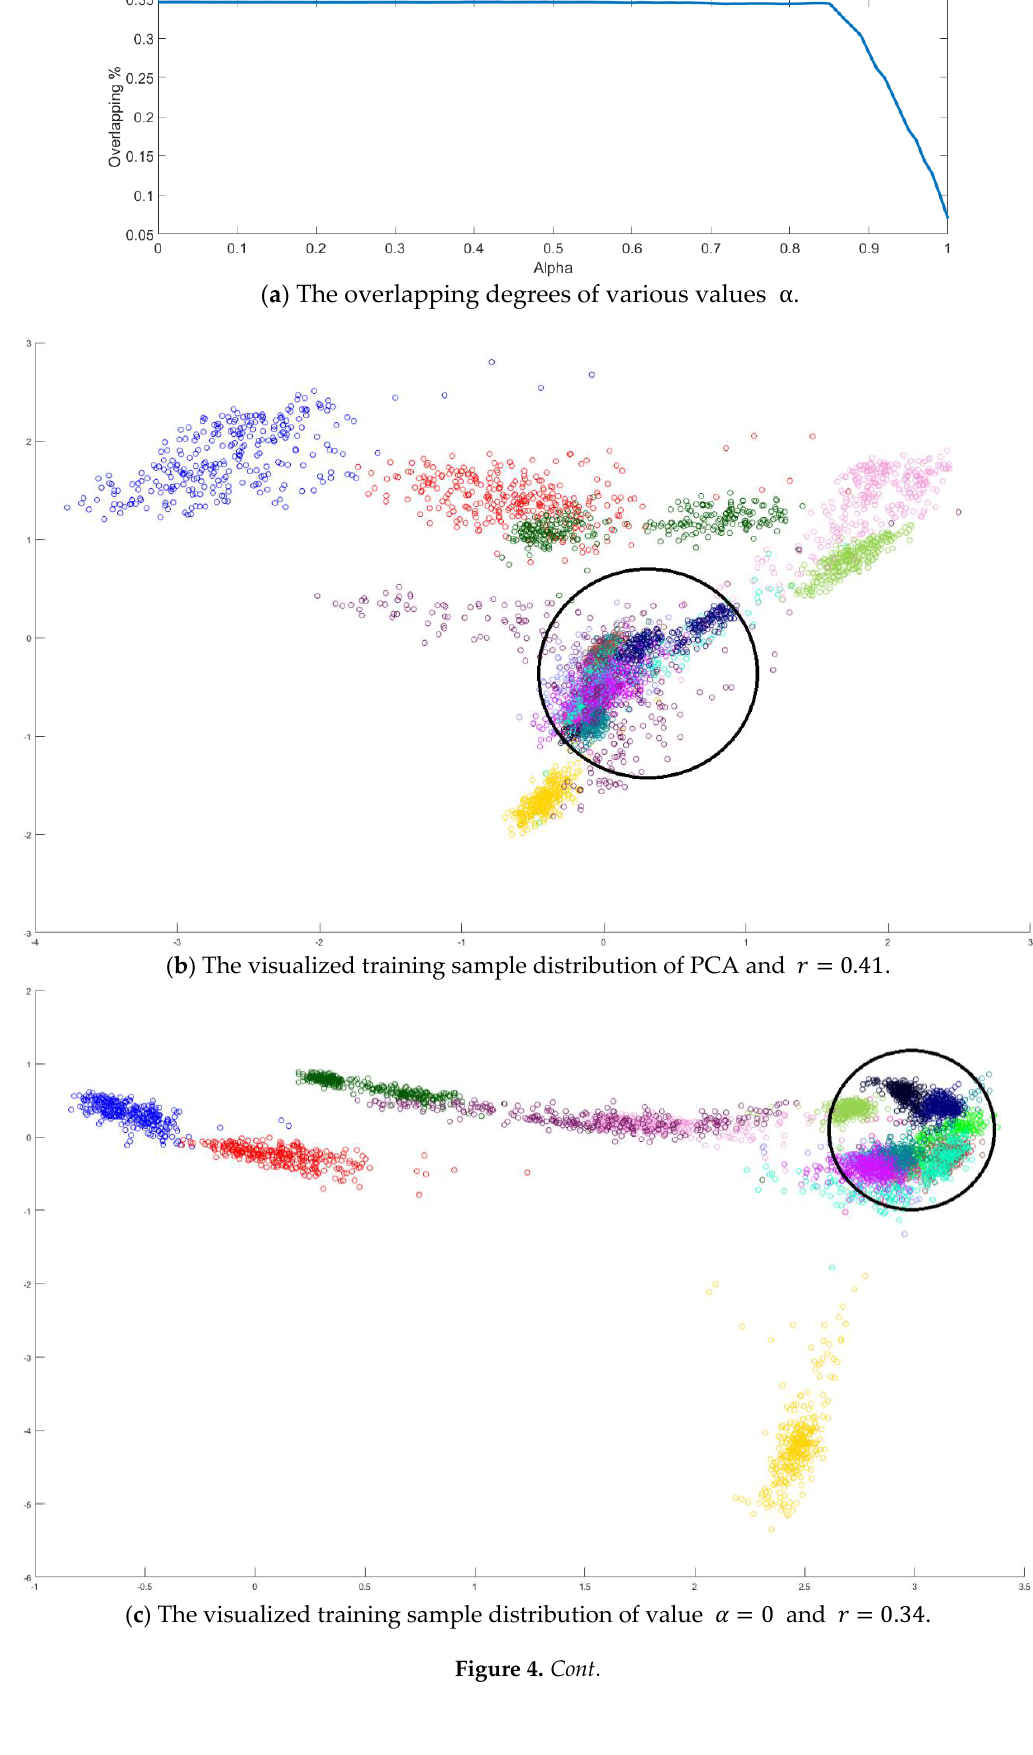
( c ) The visualized training sample distribution of value 𝛼 = 0 and 𝑟 = 0.34 . Figure 4. Cont